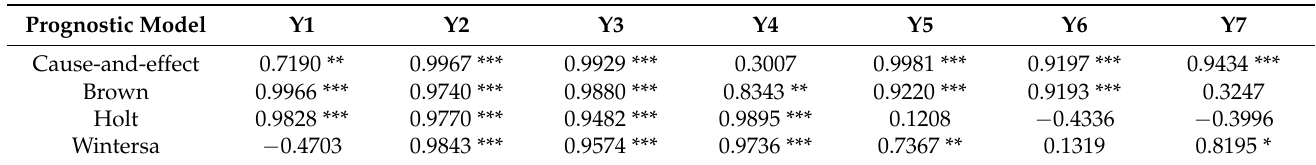
Table 6. The results of the correlation coefficients between the calculated historical forecasts and the empirical values of the forecast variables.